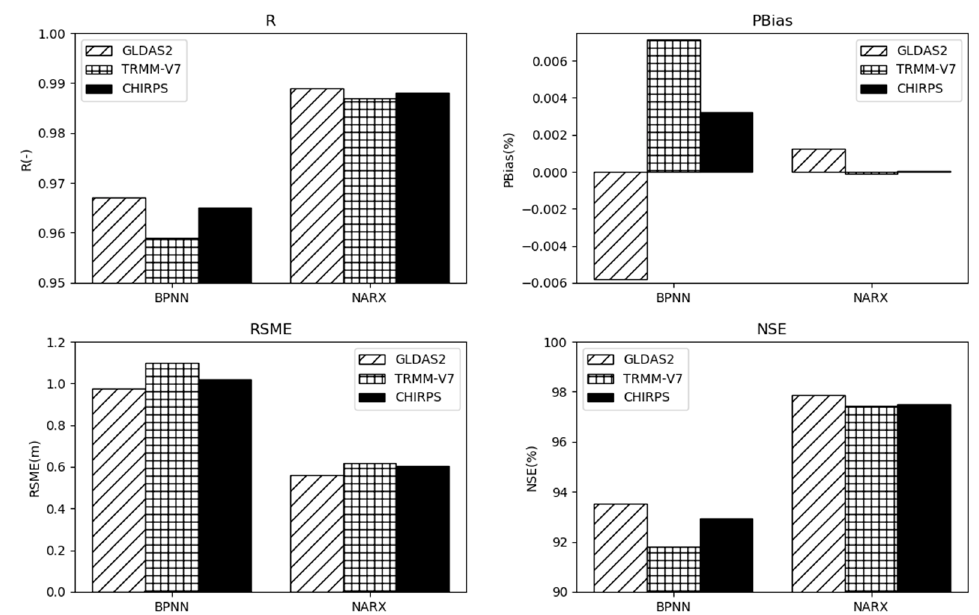
Figure 6. Comparison of water level modeling for different products.